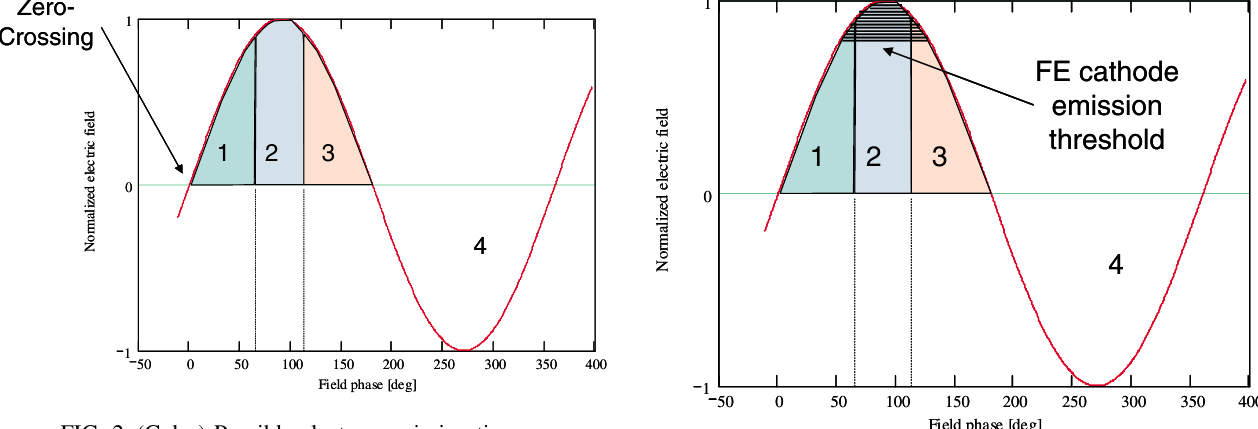
FIG. 2. (Color) Possible electron emission